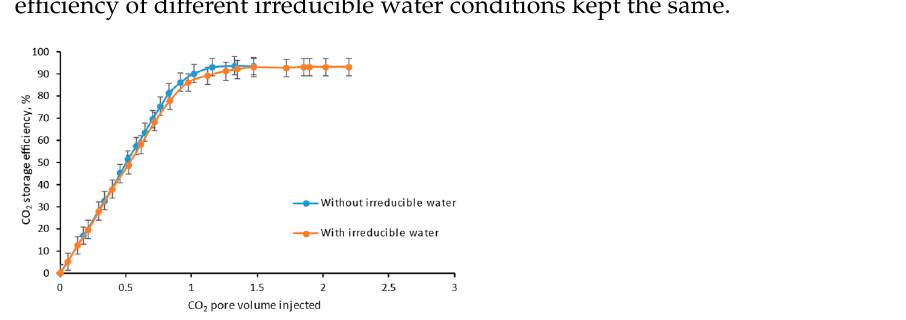
Figure 18. Relation curves between long core CO 2 storage efficiency and injection volume under different irreducible water conditions.